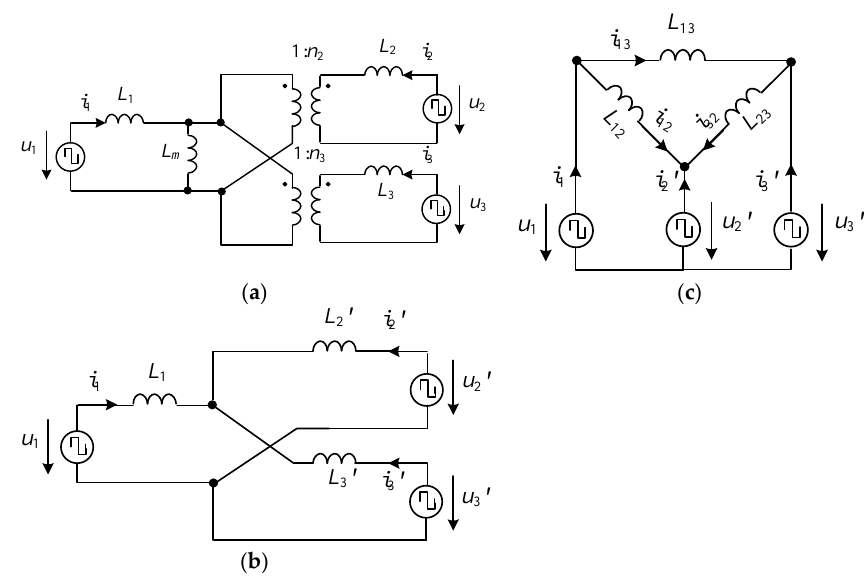
Figure 5. Equivalent model of TPI bidirectional DC/DC converter: ( a ) original equivalent model with magnetic inductance; ( b ) simplified Y-type equivalent model observed from port 1 without magnetic inductance; ( c ) simplified Δ-type equivalent mode.